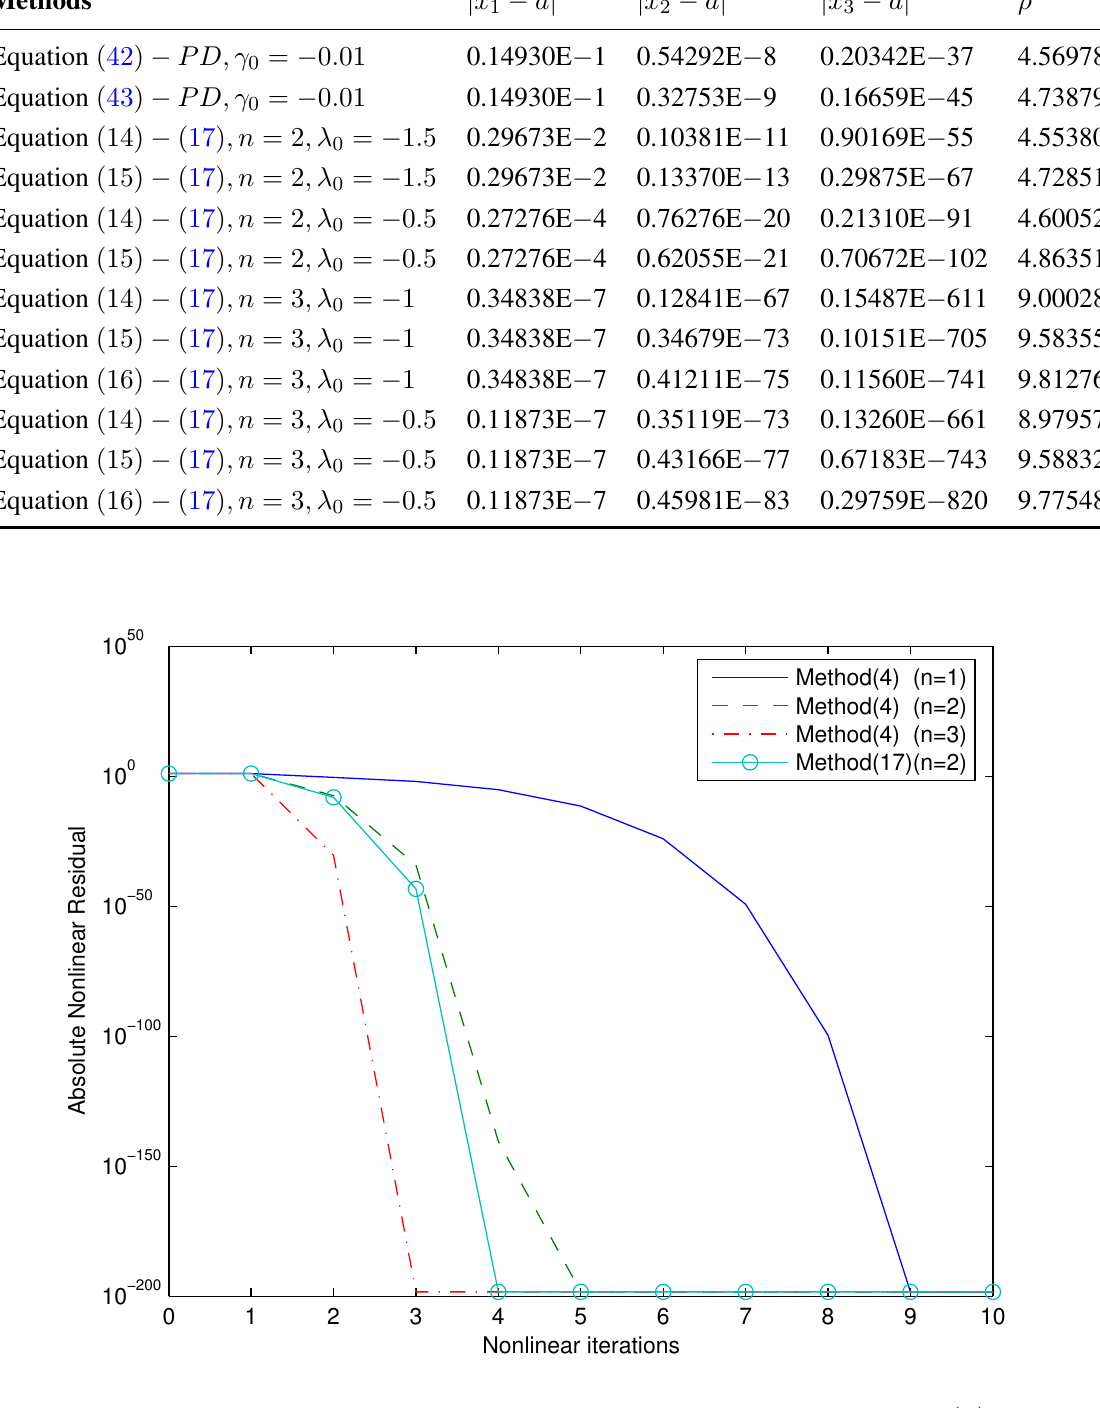
Figure 1. Iterative processes of different methods for the function f